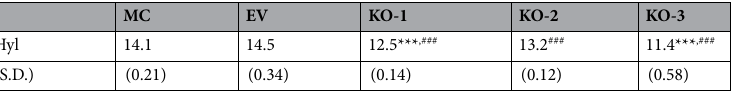
Table 2. Hydroxylation of Lys in type I collagen from controls (MC and EV), and KO clones. Values represent mean Hyl residues/mole of collagen ± S.D. (n = 3) of triplicate analysis of the hydrolysates. Statistical differences were determined by Kruskal–Wallis one-way analysis of variance and means comparison with the controls by Dunnett’s method. Lys lysine, Hyl hydroxylysine, MC MC3T3-E1, EV empty vector, KO knock-out. *** p < 0.001 between MC and KO; ### p < 0.001 between EV and KO,